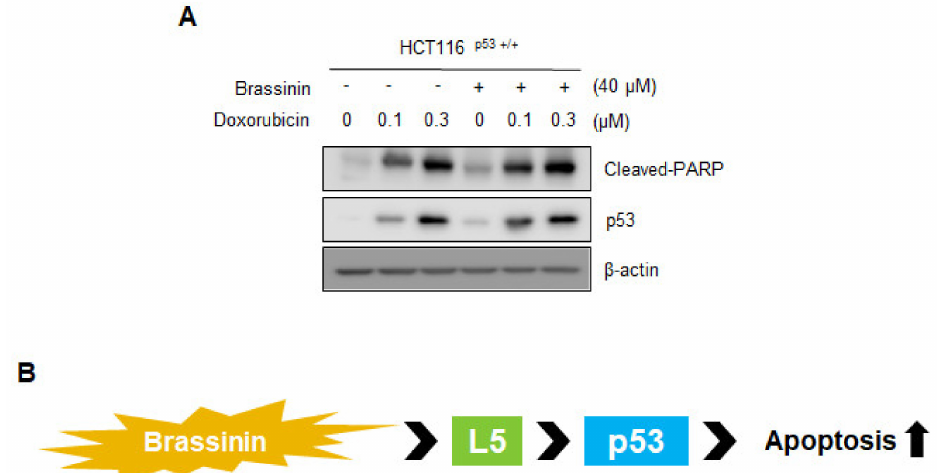
Figure 6. Combination effect of Brassinin and doxorubicin. ( A ) HCT116 p53+/+ cells were treated with or without doxorubicin for 24 h. Western blotting was conducted with antibodies cleaved-PARP, p53 and β -actin. ( B ) A mechanistic scheme for Brassinin-induced p53 dependent apoptosis via